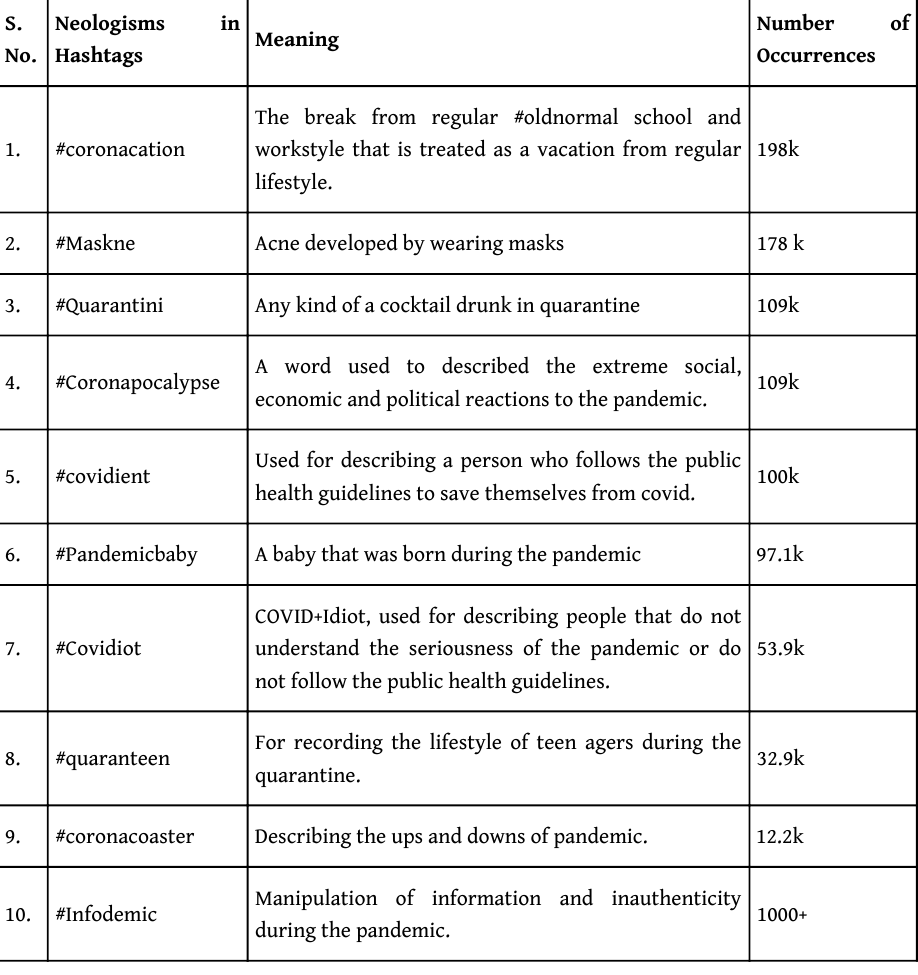
Table 10: Examples of COVID-related neologisms in Instagram hashtags